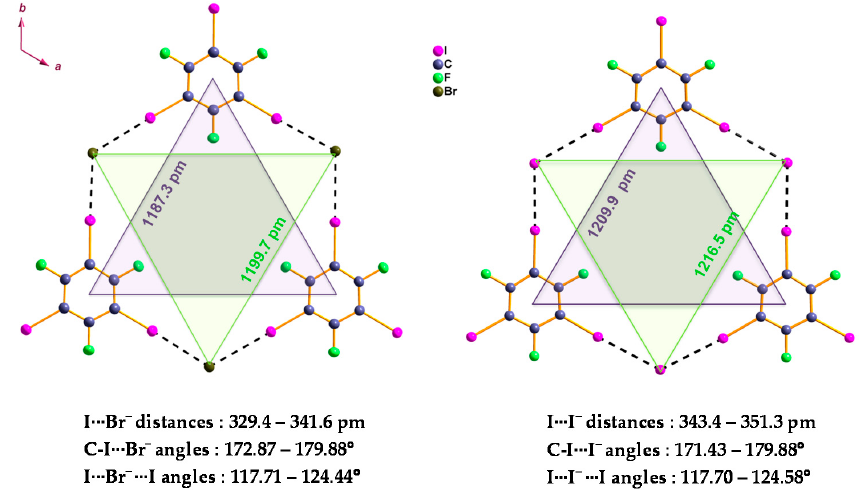
Figure 2. A view along the crystallographic c axis of one hexagonal frame of 3c ( left ) compared to the corresponding frame for 3a ( right ). Semi-transparent triangles connect the naked Br − or I − ions (greenish) and the centers of the phenyl rings of 1 (purple).